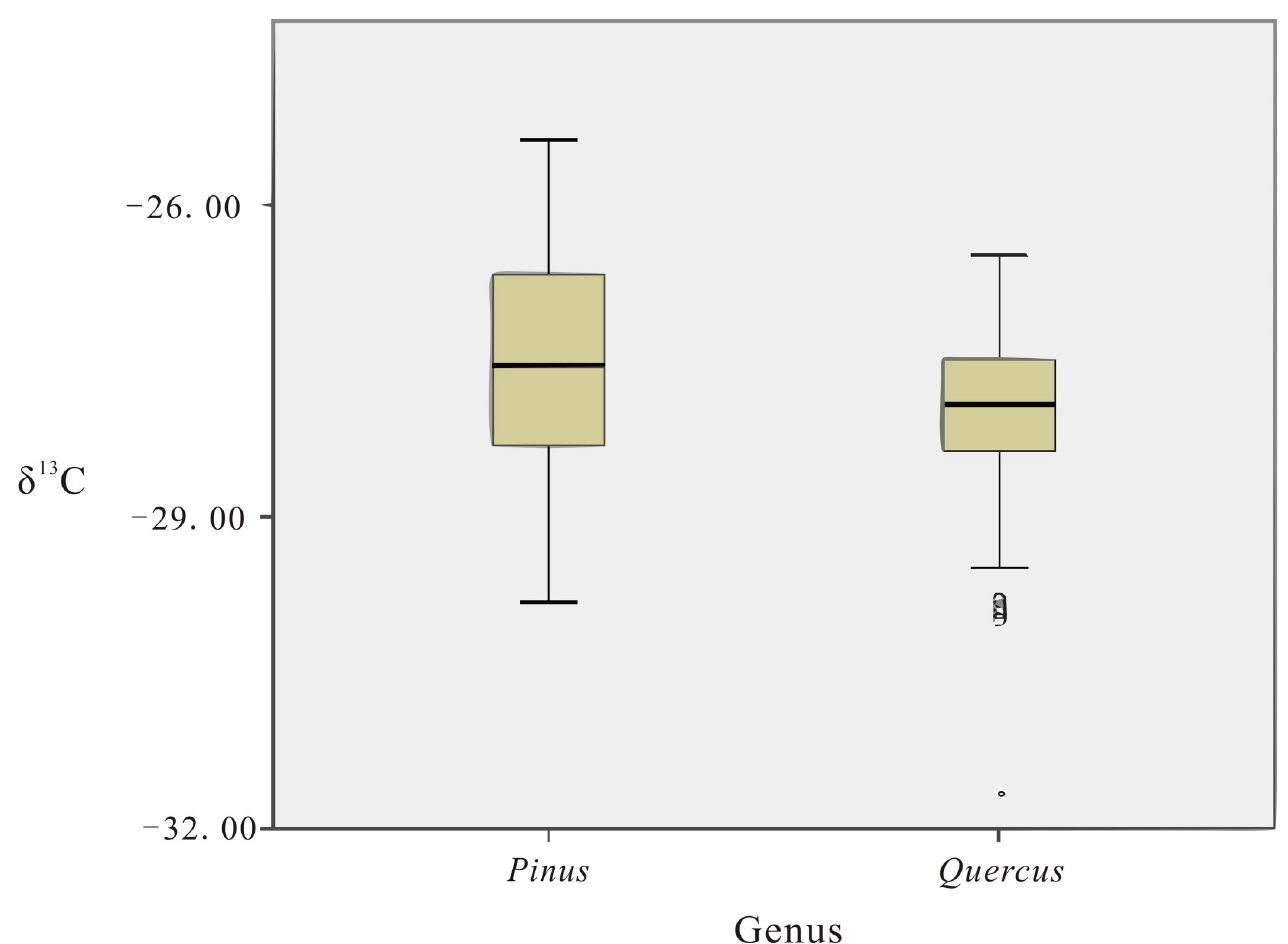
Fig 3. Comparison of δ 13 C (‰ VPDB) data for Pinus sp. and Quercus sp.